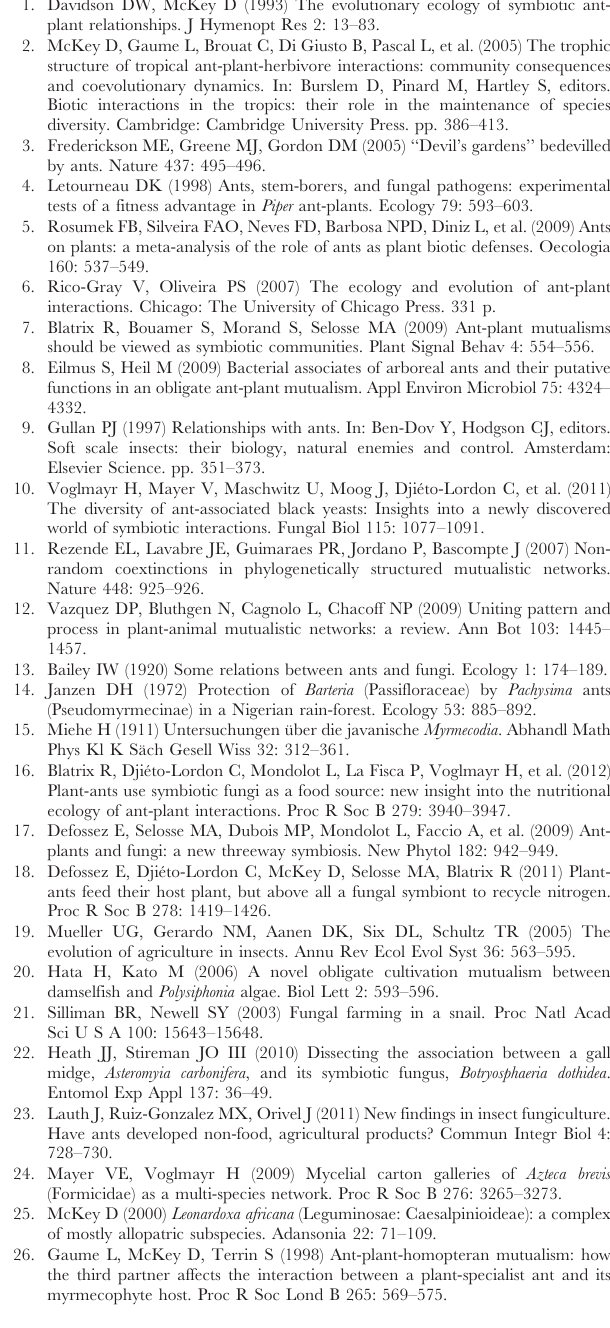
Table S1 Detailed information on each individual sample of fungal patch used in this study: code used in the laboratory where genetic analyses were performed (CEFE), species of associated plant and ant, country where the sample was collected, name of the closest village or town, date of collection, geographical coordinates (WGS84, decimal degrees), name of collector, identity of the Molecular Operational Taxonomic Unit and the corre- sponding haplotype detected using universal or specific primers or molecular cloning.